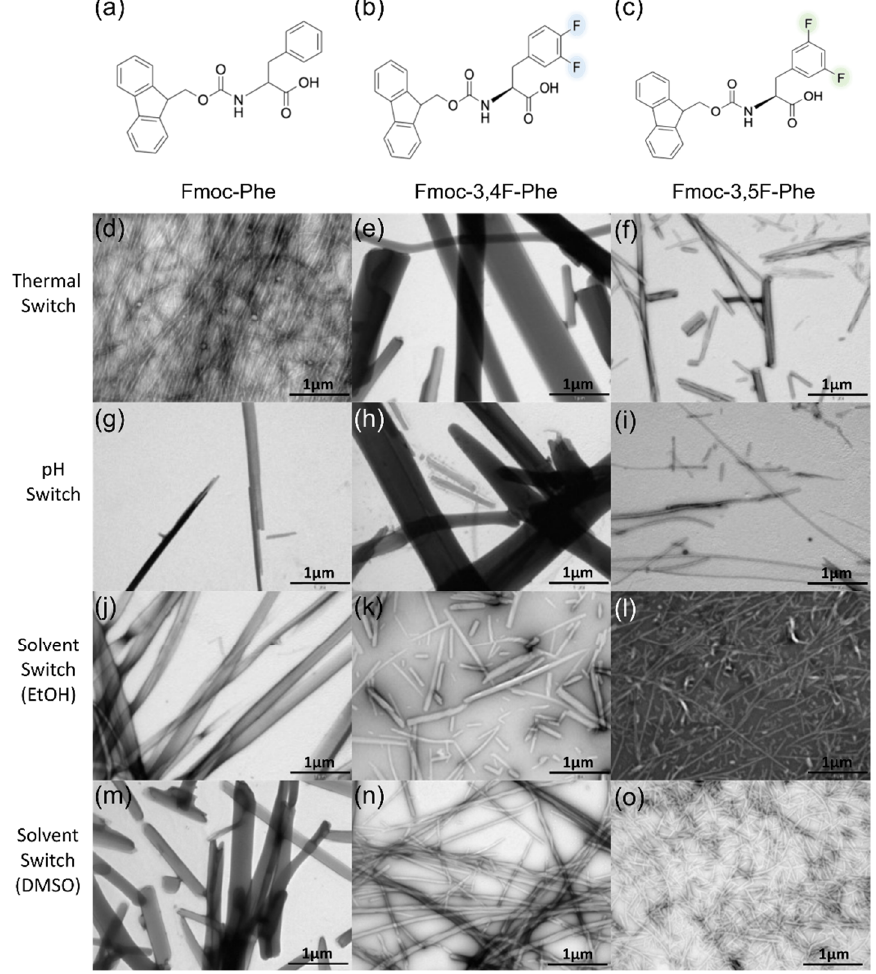
Figure 1. Formation of double fluorinated Fmoc-Phe hydrogels. Molecular structure of ( a ) Fmoc-Phe, ( b ) Fmoc-3,4F-Phe, and ( c ) Fmoc-3,5F-Phe. ( d – o ) TEM images of the structures formed by the various methods ( d – f ) Thermal Switch ( g – i ) pH Switch ( j – l ) Solvent Switch (EtOH) ( m – o ) Solvent Switch (DMSO), scale bar 1 µ